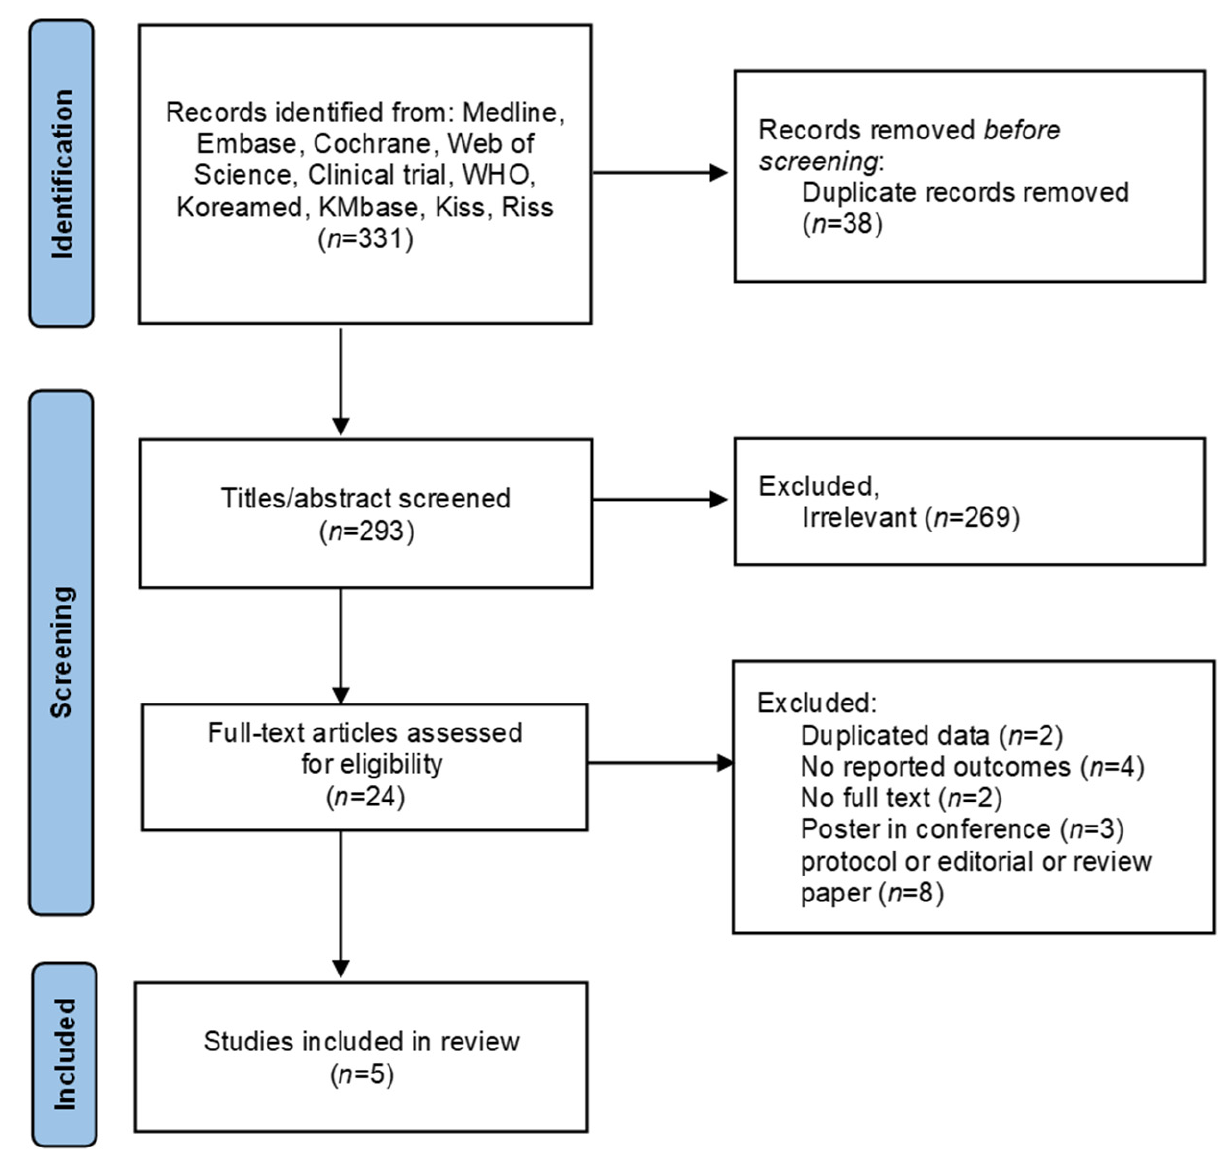
Figure 1. PRISMA flow diagram for systematic review.